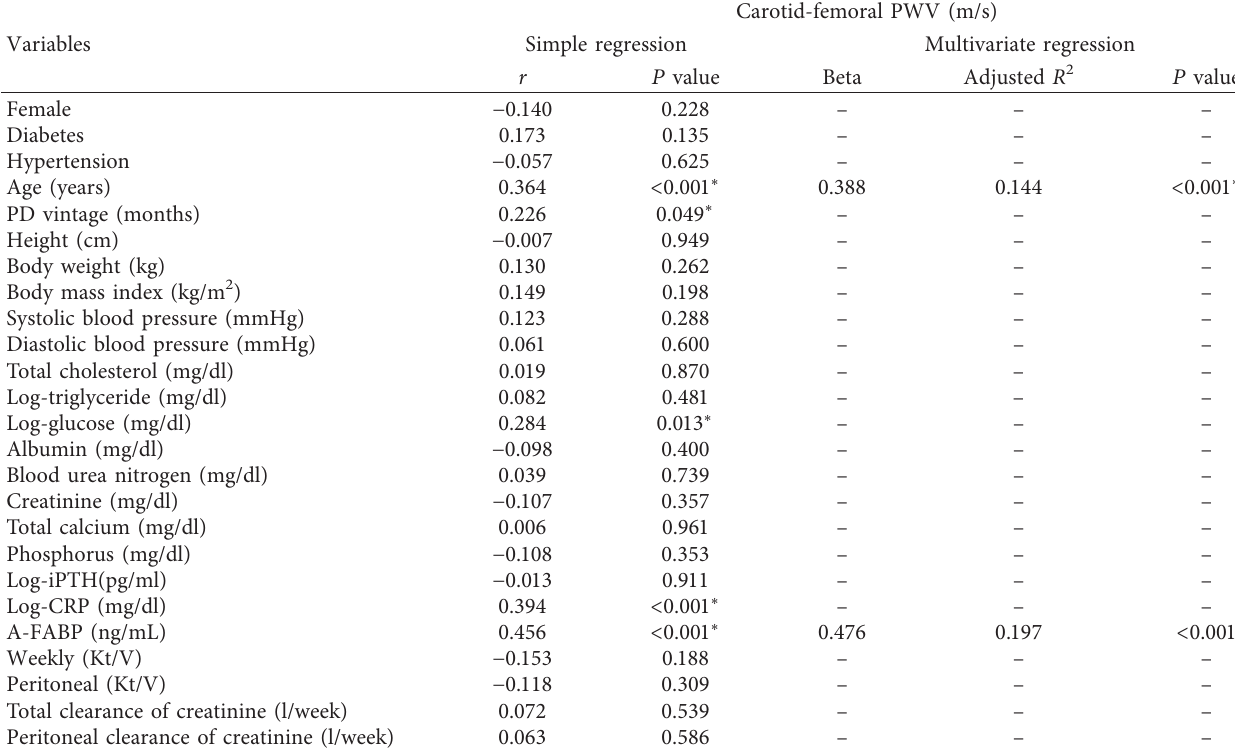
Table 3: Correlation between carotid-femoral pulse wave velocity levels and clinical variables among 76 peritoneal dialysis